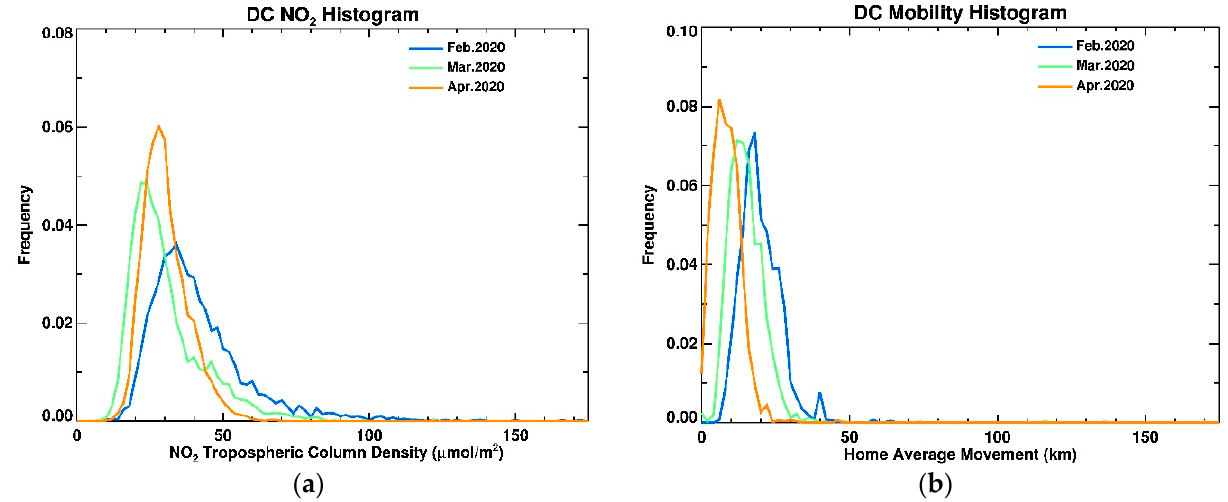
Figure 16. Histogram of NO 2 concentration in Washington, DC ( a ) and mobility distribution ( b ).